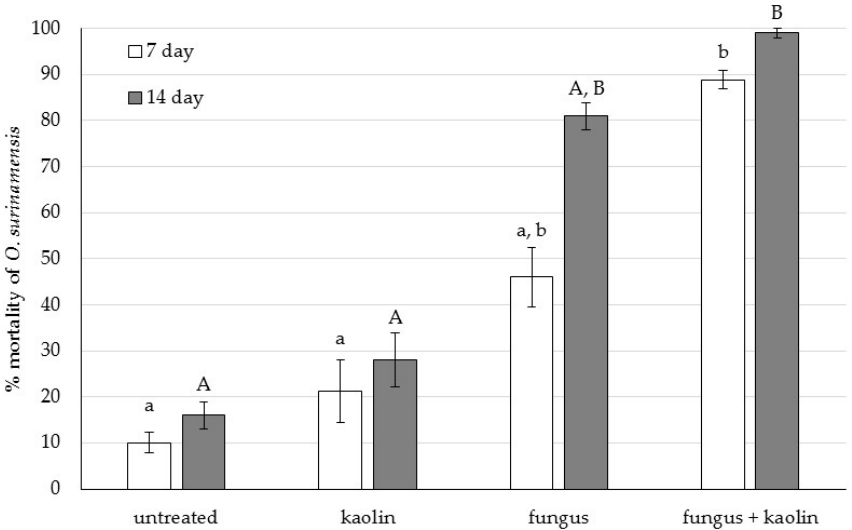
Figure 1. Bioassay 1: Percentage mortality of Oryzaephilus surinamensis adults exposed to Beauveria bassiana IMI389521 at 1 × 10 10 conidia per kg of wheat, kaolin at 1.74 g per kg of wheat, and a combination of the two, after 7 and 14 days of exposure (Mean ± SE). Different letters between groups within time points denote statistical difference among treatments ( p ≤ 0.004).